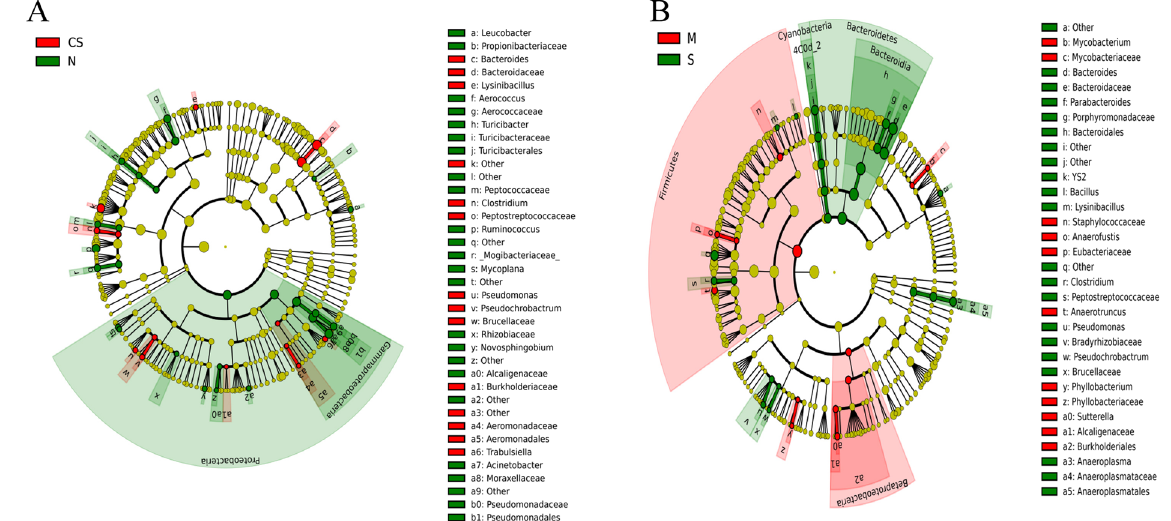
Figure 6. Graphical representation of the taxa with significantly different abundance induced by CS disaccharides under healthy ( A ) and exhaustive exercise-induced stress conditions ( B ) in a phylogenetic